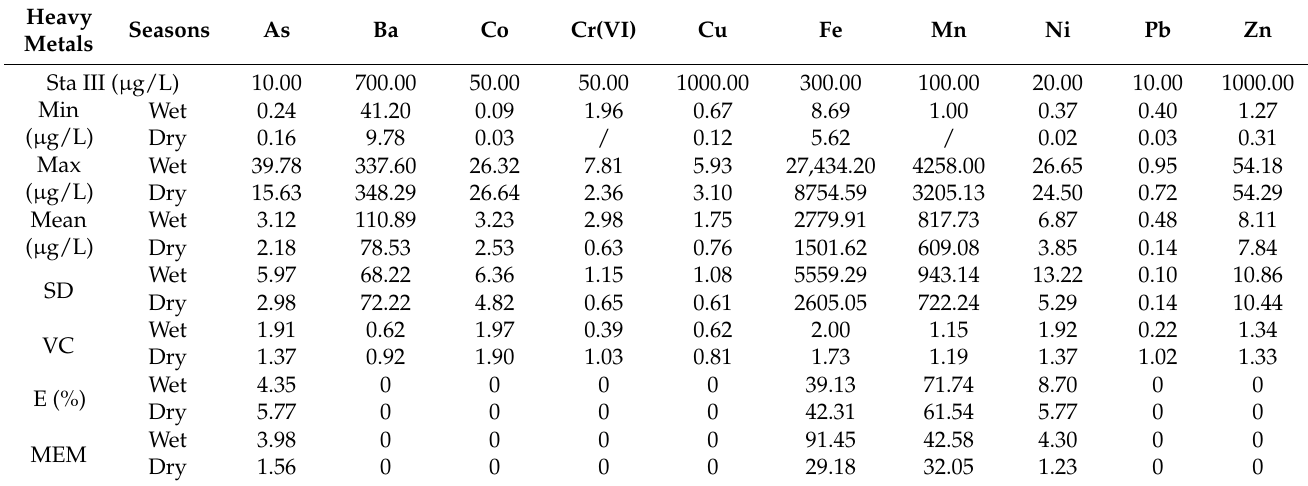
Table 1. Statistical information on the measured groundwater